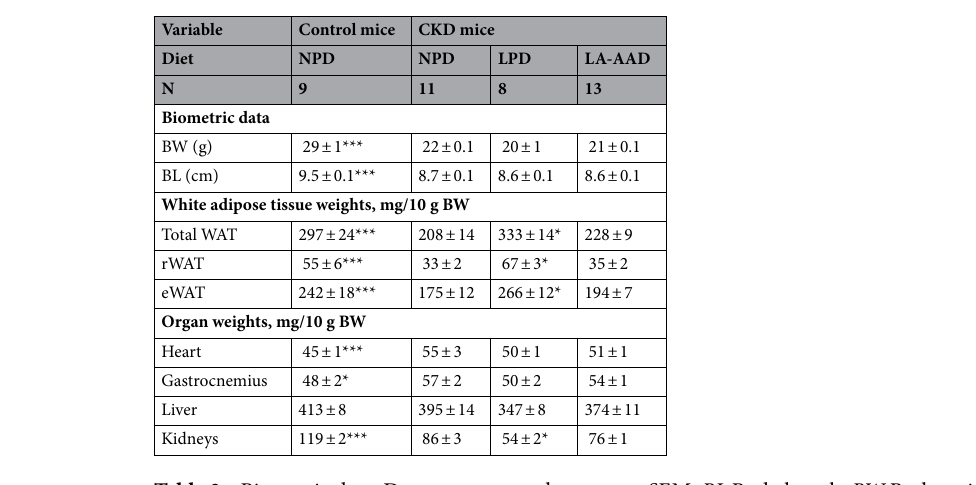
Table 2. Biometric data. Data are expressed as mean ± SEM. BL Body length, BW Body weight, NPD Normoproteic diet, LPD Low protein diet, LA-AAD Low aromatic amino-acids diet, WAT White